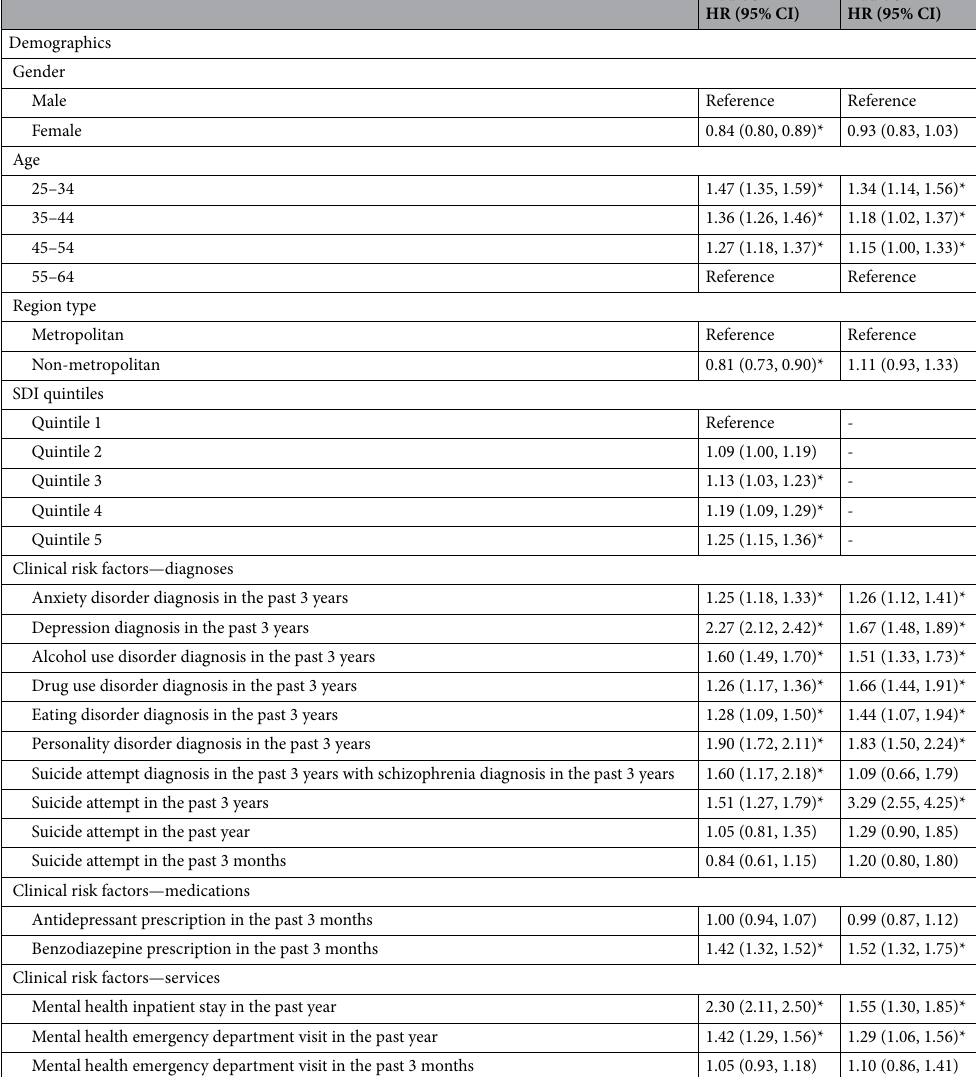
Table 2. Survival analysis of suicidal ideation and suicide attempt results for commercially insured adult patients following an outpatient mental health visit. # The model for SA did not have SDI because SDI was not significant when Model 3 was compared to Model 2, and therefore dropped in the final model. *Indicates CI did not cover